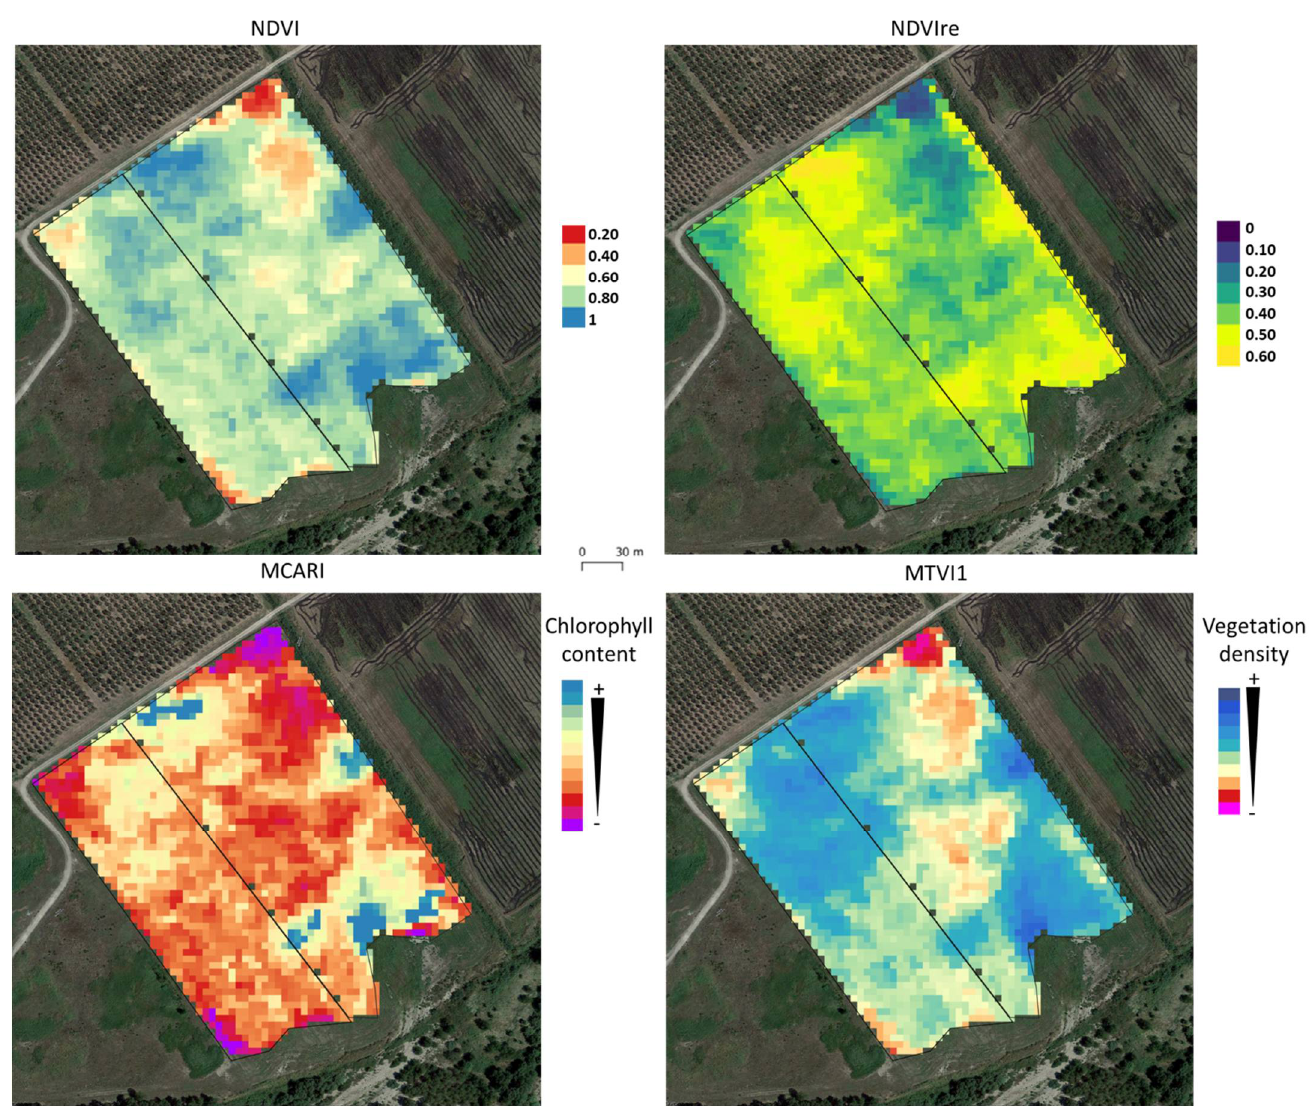
Figure 10. Maps of multispectral indices obtained from elaboration of the RapidEye satellite data for the DV site (municipality of Lavello) with the Anco Marzio durum wheat cultivation for the NDVI, NDVI-RE, MCARI, and MTVI1. The black line circumscribes the sub-areas managed with conservative (no tillage, left side) and conventional (deep tillage, right side) practices.